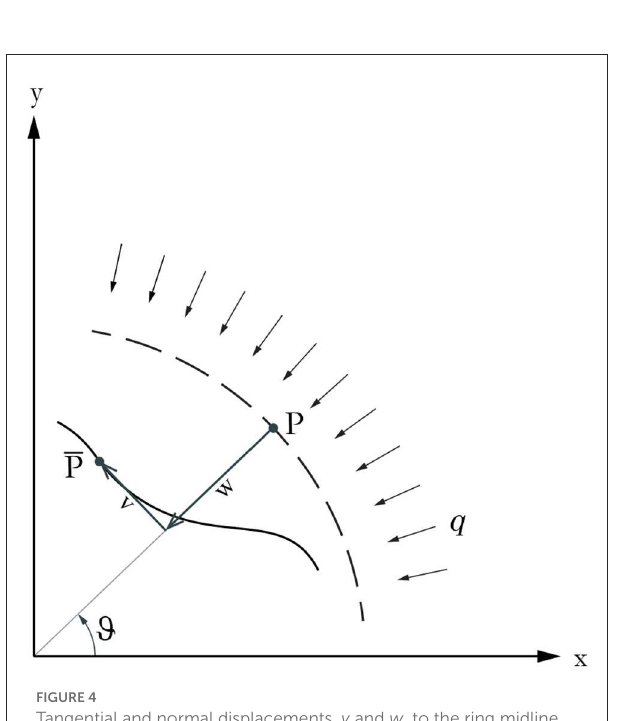
FIGURE4 Tangential and normal displacements, v and w , to the ring